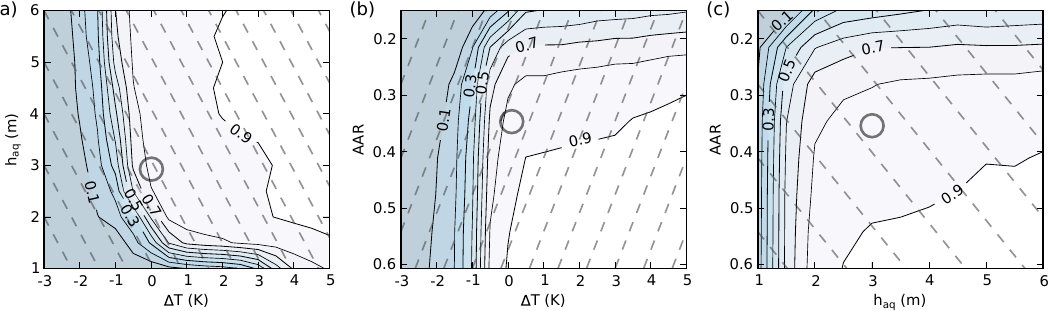
Fig. 6. The effect of varying pairs of variables on temperate ice fraction (contour interval is 0.1). Equilibrium line altitude has been recast as accumulation area ratio. Air temperature offset ( ∆ T ) and aquifer thickness ( h aq ) are co-varied in (a), air temperature offset ( ∆ T ) and AAR in (b), and aquifer thickness ( h aq ) and AAR in (c). The simulations shown use the enhanced flow coefficient ( A e ). The circles indicate the reference parameter combinations. Dashed lines denote hypothetical trajectories through the parameter space based on a linear mass balance sensitivity and a constant lapse rate. See text for details.